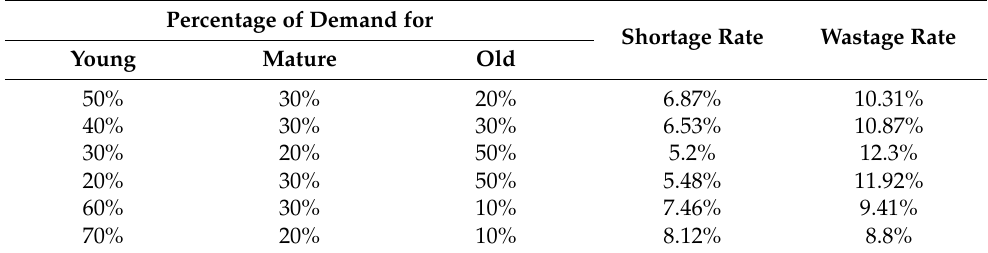
Table 5. Effect of demands with different ages of platelets on shortage and wastage rates.